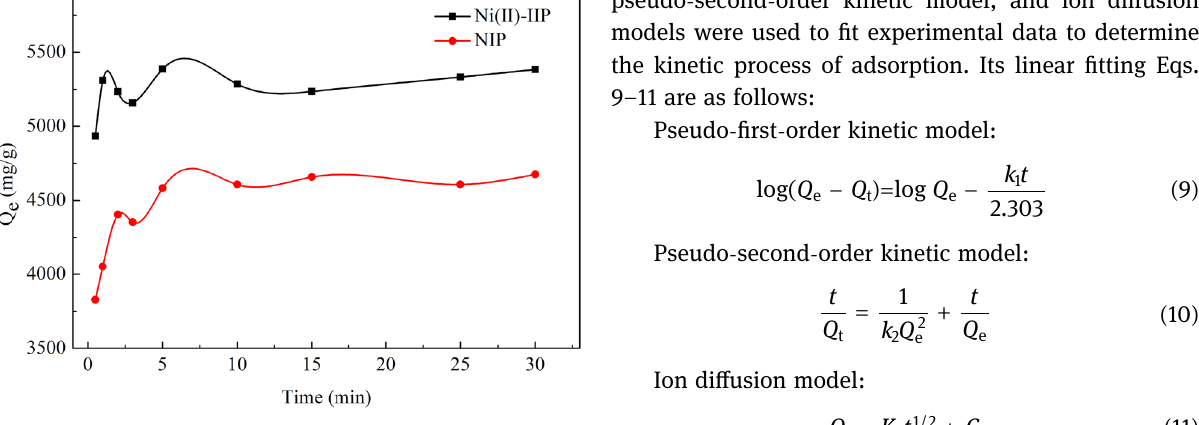
Figure 8: The kinetic adsorption curves of Ni ( II )- IIP 5 and NIP 5